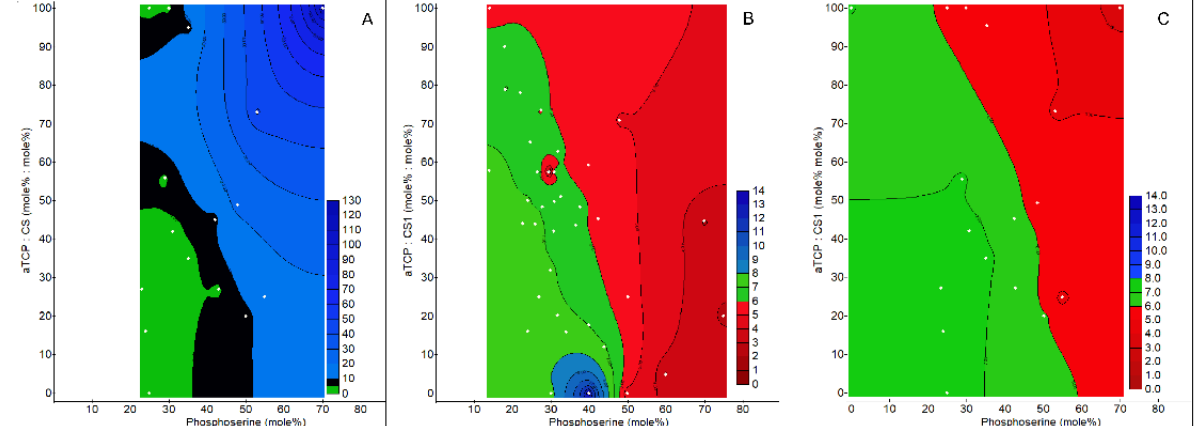
Figure 3. Formulation plots comparing the effect of composition on setting time and pH, in “as obtained” extracts, according to ISO 10993. ( A ) Initial setting time (Gilmore needle) for PMCs formulations (<2 min setting = green, 2–10 min = black, and >10 min = blue regions). pH of extracts when samples were cured ( B ) for an arbitrarily fixed time (5 min), or ( C ) to the initial setting time for each formulation (pH > 7.6 = blue, pH < 7.2 = red, pH 7.2–7.6 = blue region). Sample